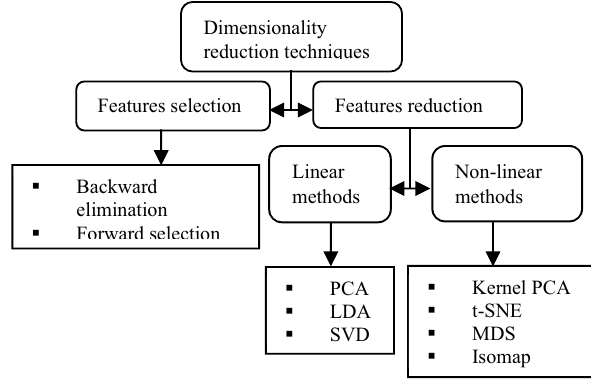
Figure 1. Dimensionality reduction